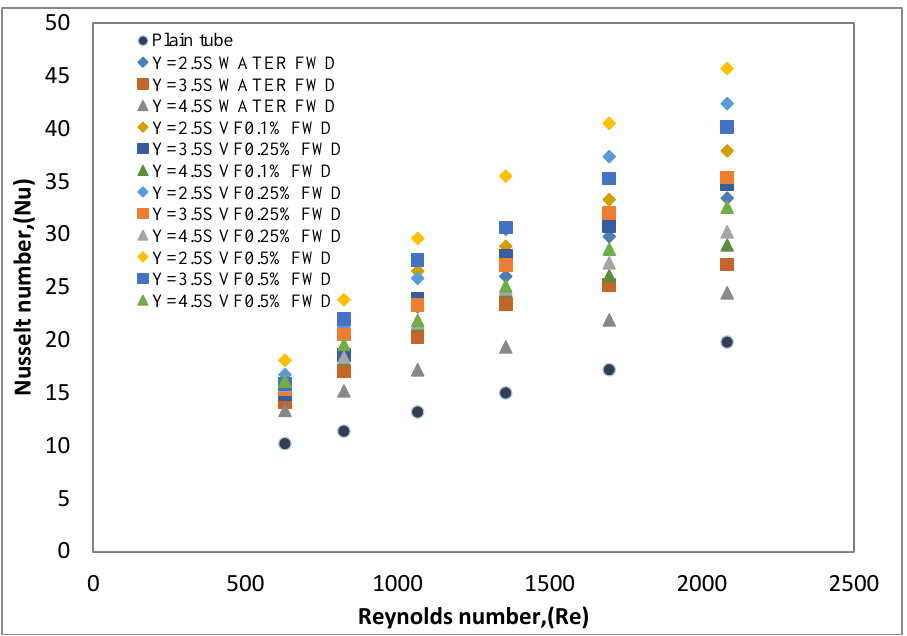
Figure 10. Nusselt number versus Reynolds number for the staggered conical strip insert with a forward arrangement using deionized water and ZrO 2 / deionized water nanofluids under laminar flow conditions.